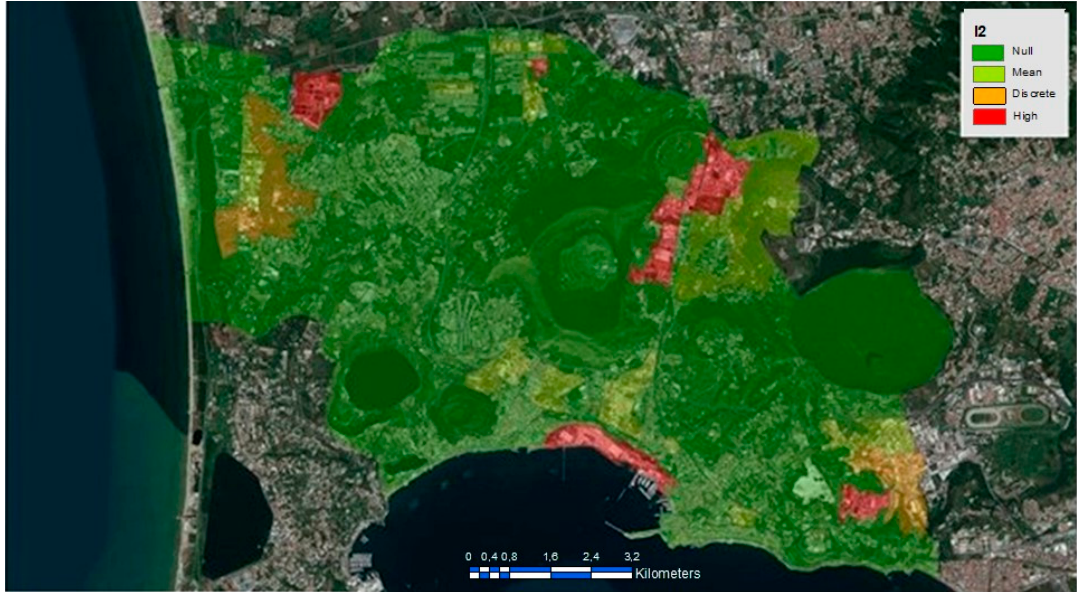
Figure 9. Thematic map of the indicator I 2 in which each microzone is classified by assigning it the label of the fuzzy sets to which it belongs with the highest membership degree.